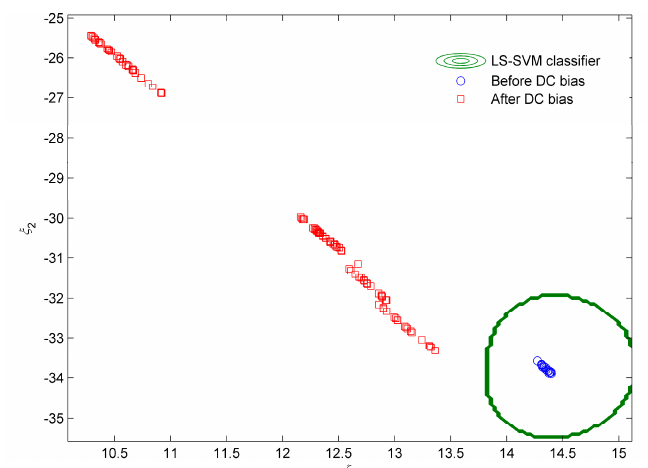
Figure 8. Principal vibration features of DC-biased power transformers.